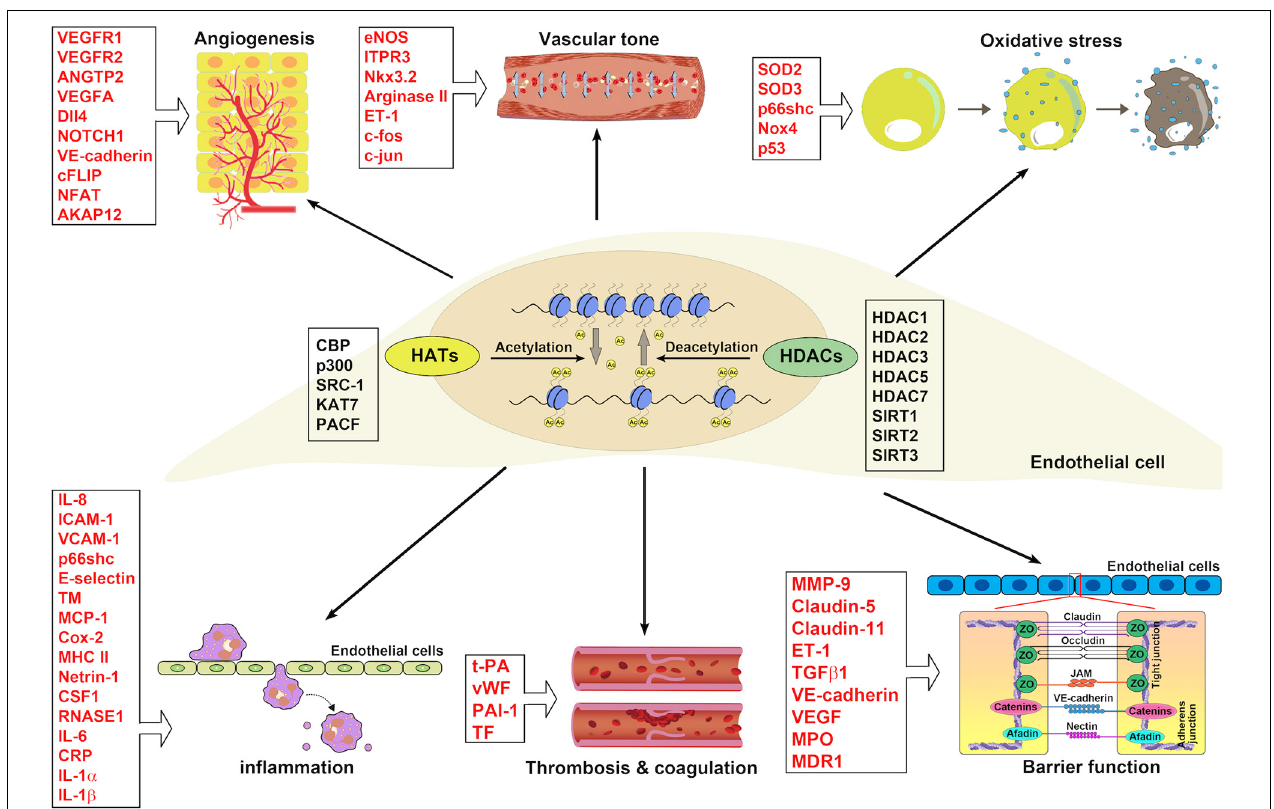
FIGURE 4 | The implications of HATs and HDACs in ECs associated with blood vessel functions. HATs and HDACs have been demonstrated to modulate the histone acetylation of ECs involving blood vessel functions: angiogenesis, vascular tone, oxidative stress, inflammation, thrombosis and coagulation, and barrier